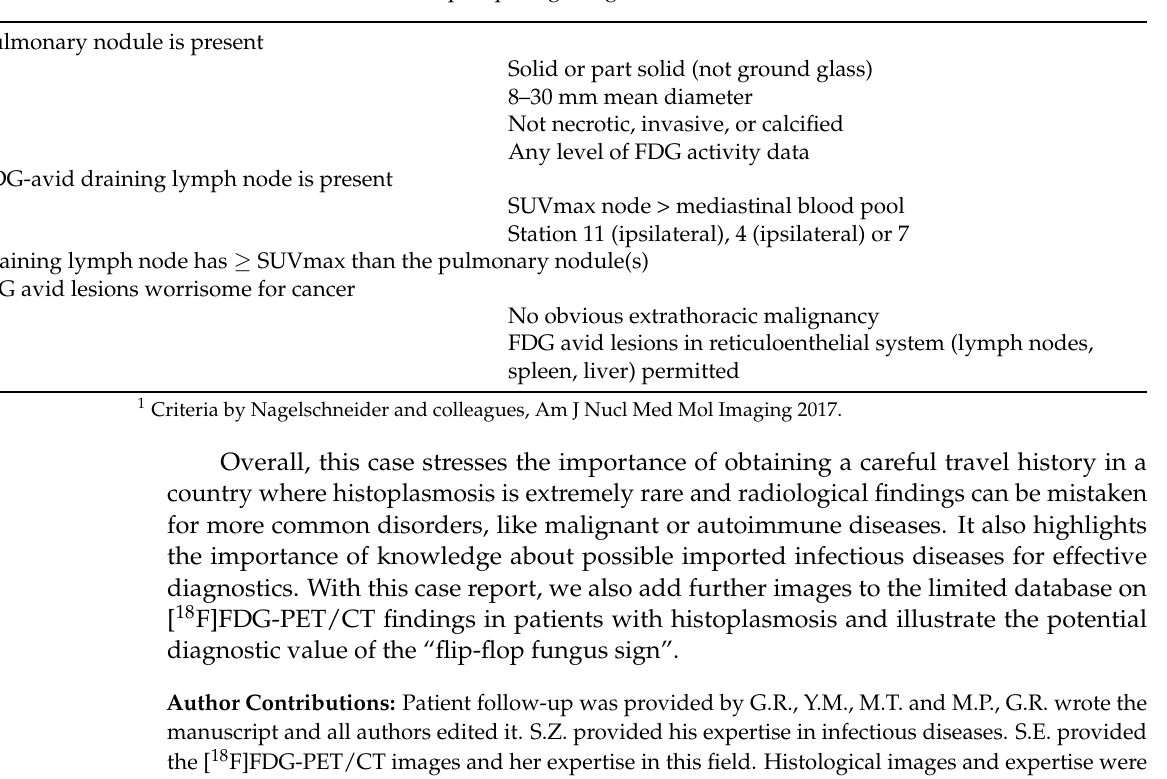
Table 1. Positive flip-flop fungus sign criteria 1